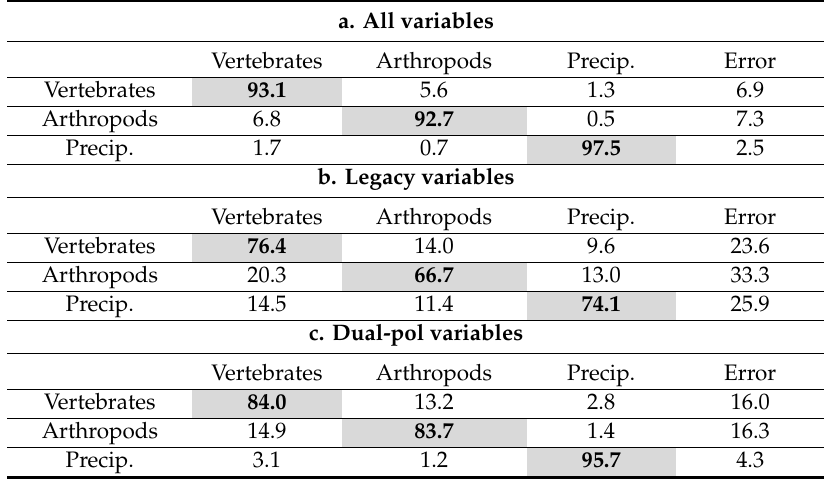
Table 6. Three-class multinomial RF model results showing classification of validated scatterers in the non-training set. Values are percent of the total out-of-bag samples assigned to that class. Results are given for models based on three di ff erent variable combinations, (a) all six variables, (b) three legacy variables (Z H , Vr, σ V ), and (c) three polarimetry variables (Z DR , ρ HV , Φ DP ). Percent true positive classifications are highlighted and bold. Percent classification error is summed to the